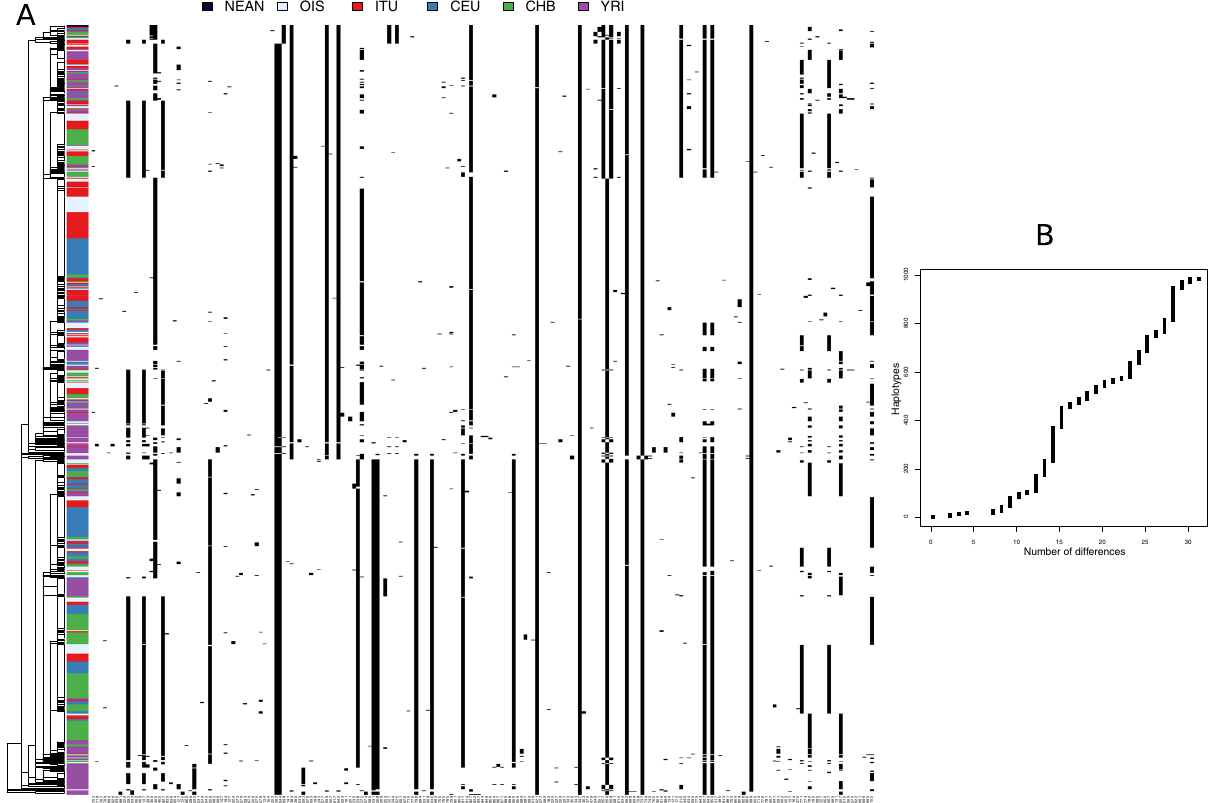
Figure 2. Haplostrips plot of AHNAK2 gene: ( A ) Clustered and sorted by increasing distance with Neanderthals. A few Neanderthal derived SNPs show a pattern of unique haplotype sharing among the continental populations. However, none of these SNPs were found in high PBS value during selection scan and therefore have no significance in the adaptive role of AHNAK2 in this study. Population label abbreviations are as follows: NEAN Neanderthal, OIS Our Indian Samples, ITU Indian Telugus, CEU Central Europeans from Utah, CHB Chinese Han from Beijing, YRI Yoruba. ( B ) This plot visualizes the extent of closeness (based on SNP difference) between the haplotypes shared by continental populations and